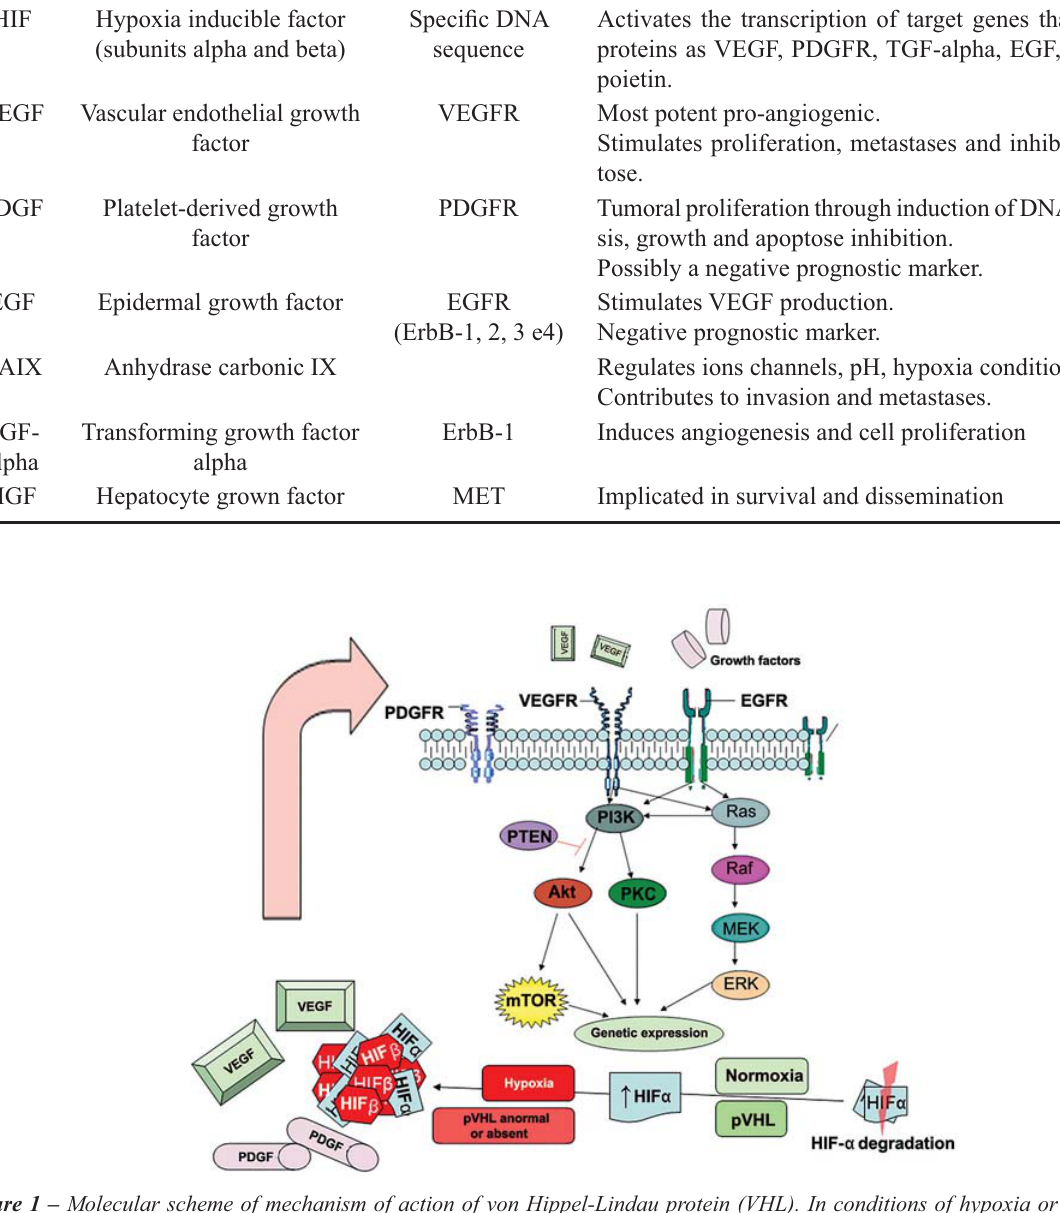
Figure 1 – Molecular scheme of mechanism of action of von Hippel-Lindau protein (VHL). In conditions of hypoxia or VHL gene inactivation and consequently, absence of codified protein (pVHL), there is no formation of complex formed by the binding of hypoxia inducible factor (HIF) and hydroxyproline residue. Therefore, there is no HIF degradation, resulting in accumulation of HIF in nucleus and promoting oncogenesis, through super-expression of encoding genes implicated in: tumoral angiogenesis (vascular endothelial growth factor [VEGF]), glucose transport (GLUT1, GLUT3), glycolisis (fosfofrutose-6 quinase-2), pH control (cabonic anhydrase family, CA IX), endothelial proliferation (platelet-derived growth factor [PDGF], transforming growth factor-alpha [TGF-alpha]), erythropoietin (EPO), cellular migration (CXCR4) and apoptosis (Bid, Bax, Bad)